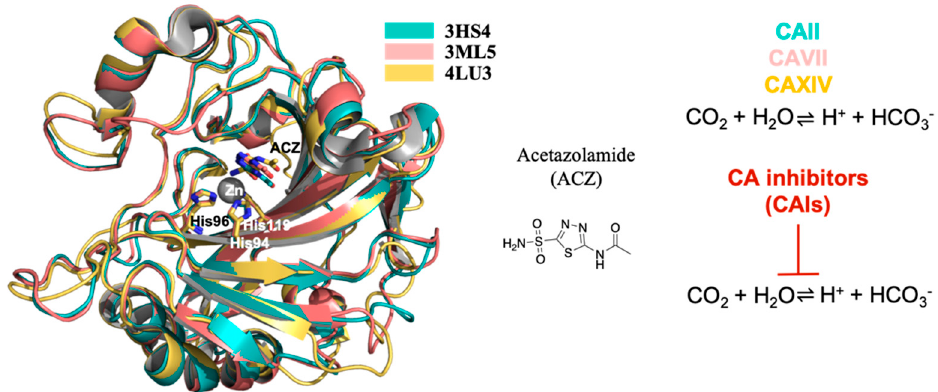
Figure 1. Superposition of human CAII, VII and XIV in complex with acetazolamide (ACZ). In the middle chemical structure of ACZ, on the right CAs activity and CAIs action. All the structural figures have been made with PyMol [12] modifying the scripts previously used [13,14] and the images were assembled using GNU Image Manipulation Program (GIMP) [15].